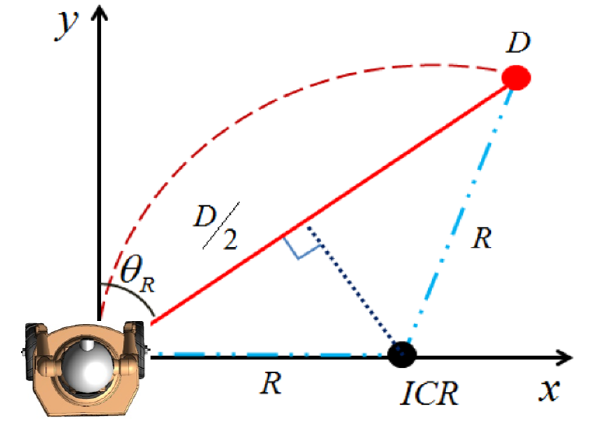
Figure 24. Radius of rotation based on the location of the moving